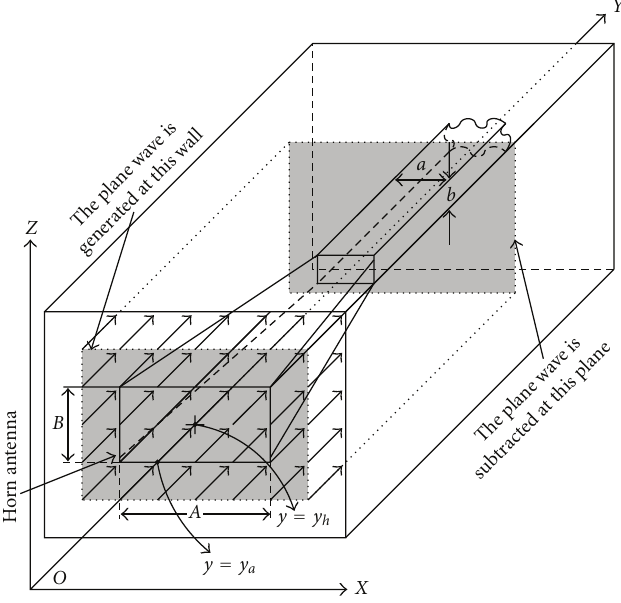
Figure 2: Receiving antenna case. A horn antenna under plane-wave illumination within the FDTD